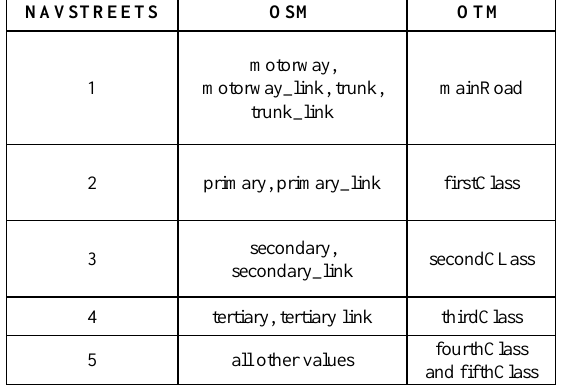
Table 3. Attribute mapping between NAVSTREETS Street Data Functional Class and OSM and OTM datasets